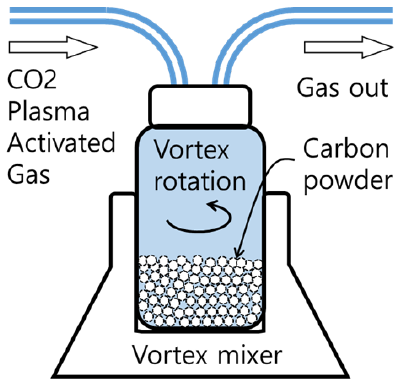
Figure 1. Schematic of a batch-type reactor for the carbon powder treatment with the CO 2 plasma- activated gas (PAG).